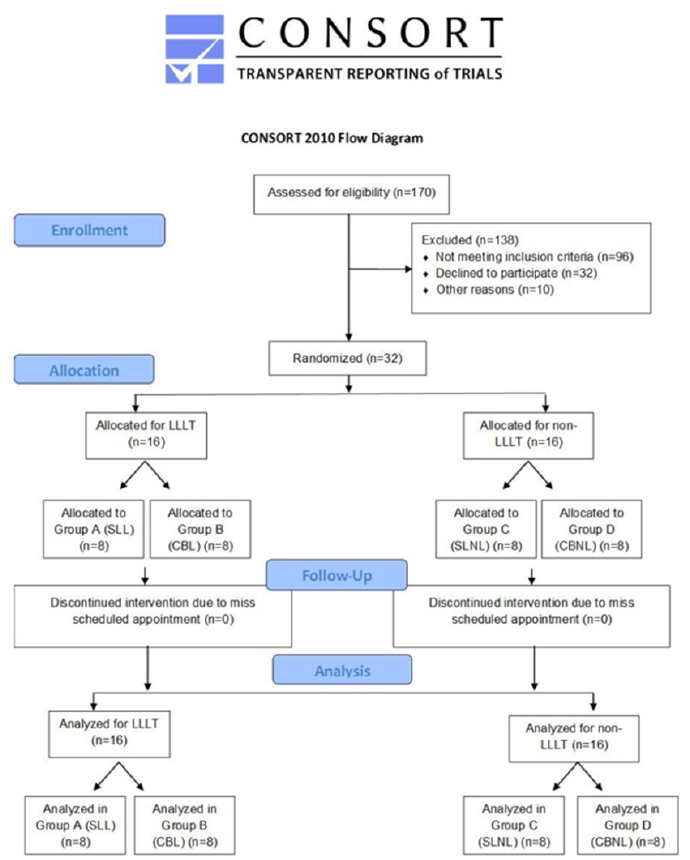
Figure 1. CONSORT guidelines flow diagram.